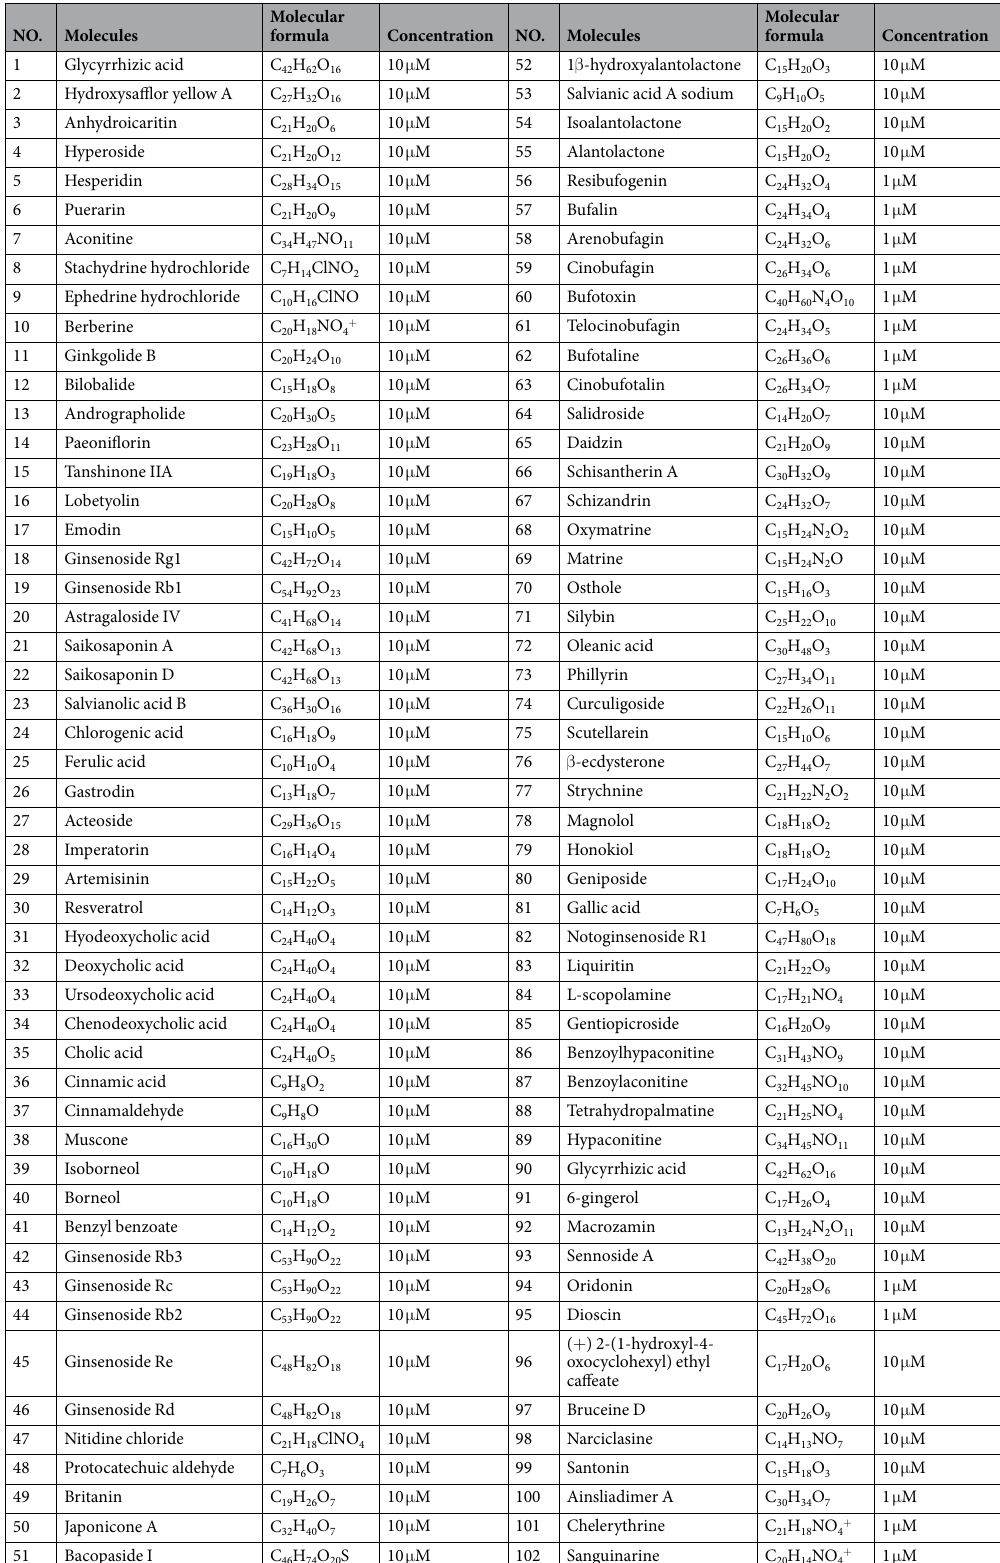
Table 1. The list of 102 molecules in